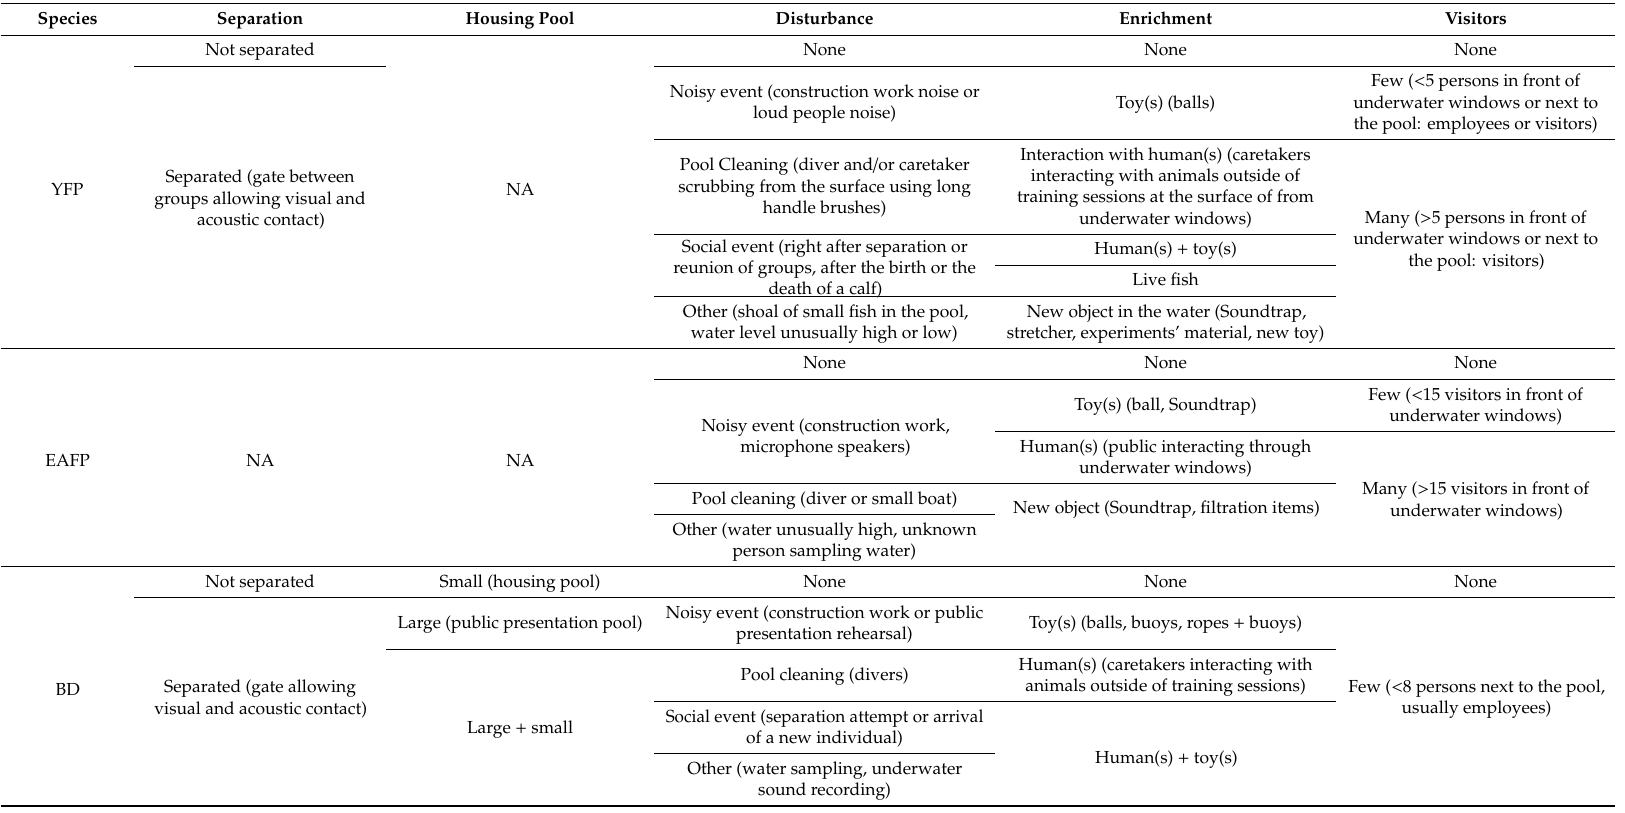
Table 3. Environmental and social factors’ features (adapted from Serres et al.